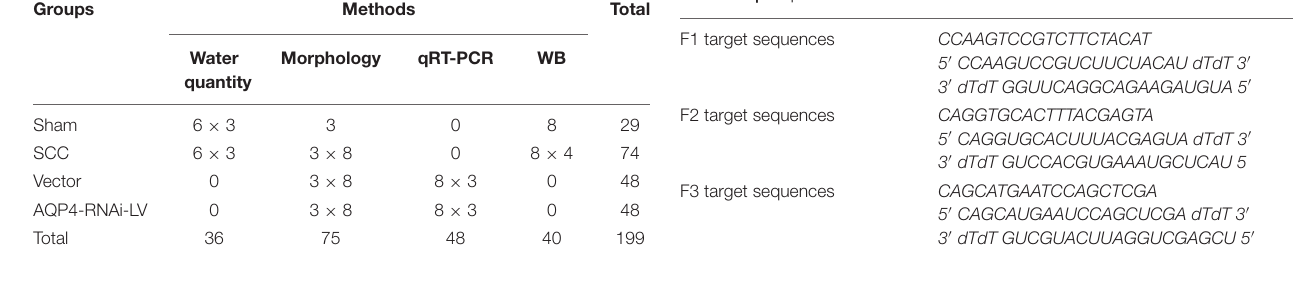
TABLE 2 | Sequence information of AQP4